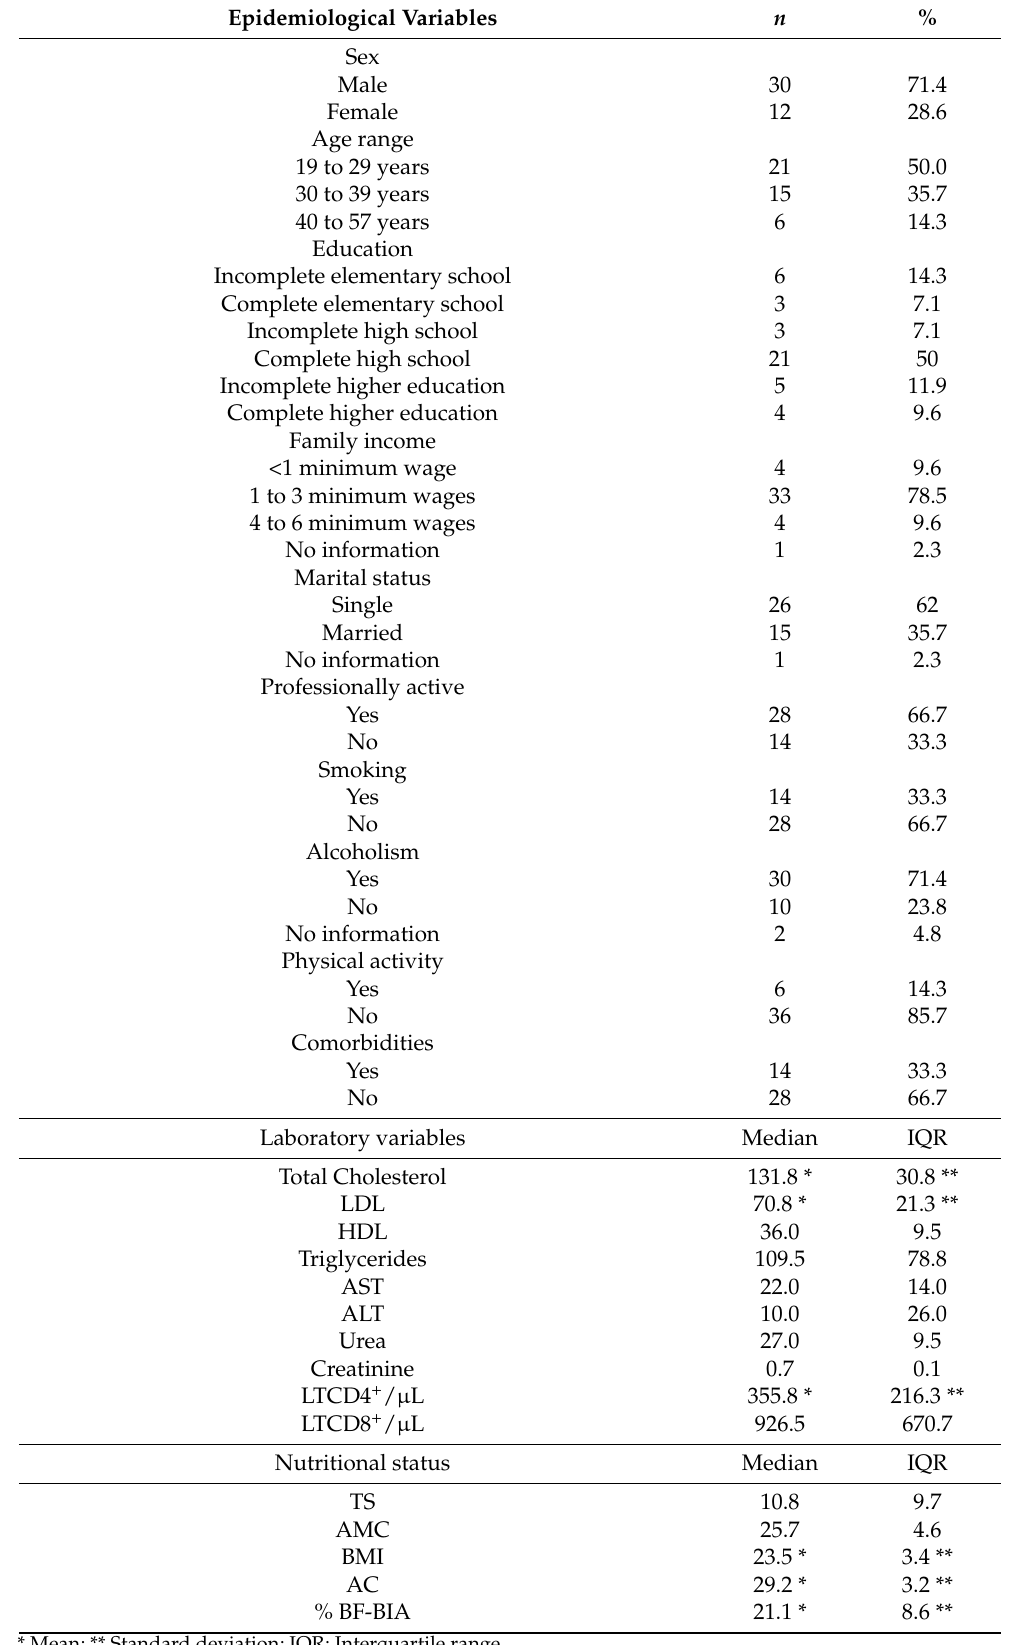
Table 1. Epidemiological, laboratory and nutritional characterization of PLHIV before starting ART